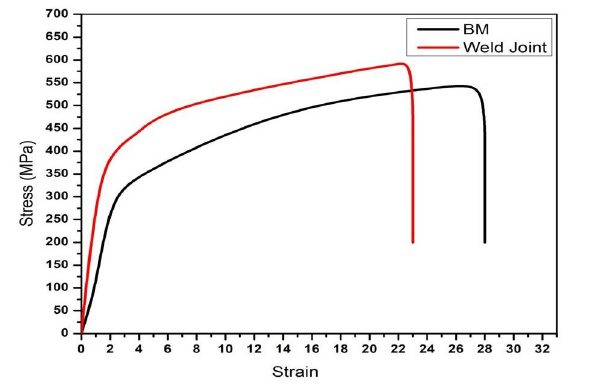
Figure 9: Stress – Strain curves for the base metal and welded joint